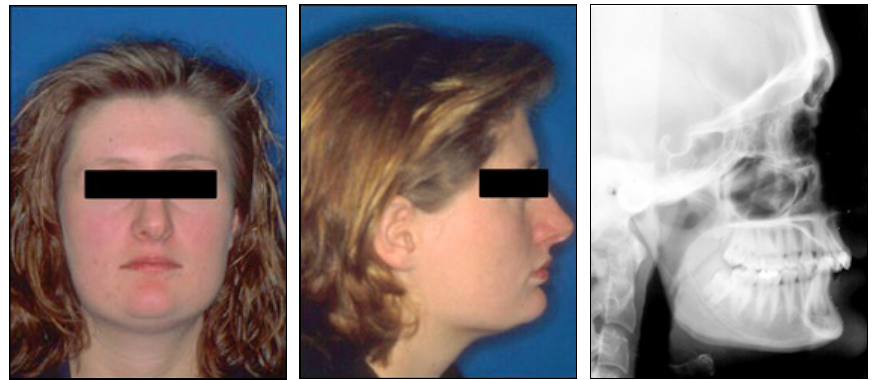
Figure 1. Pre-surgical photographs and cephalogram exemplifying a patient treated by clockwise rotation of the occlusal plane during orthognathic surgery.